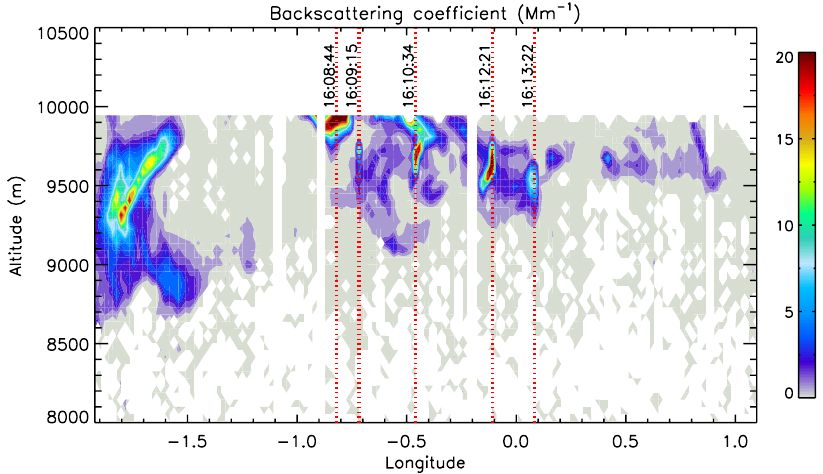
Fig. 7. Lidar-derived backscattering co-efficient (with marked contrail locations based on NAME model output) for the SLR (Run 1) at higher altitude from 16:03:00 to 16:18:35, contrail signals are noted between − 1.0 and 0.5 degrees latitude, with earlier contrails detected further to the east. The larger signal on the left from 8600–10000m shows a contrail from another aircraft.